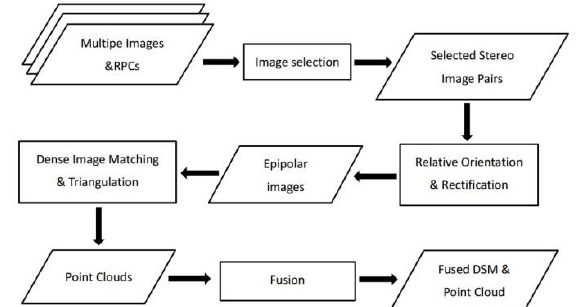
Figure 1. Workflow of the point cloud and DSM generation from the MVS satellite